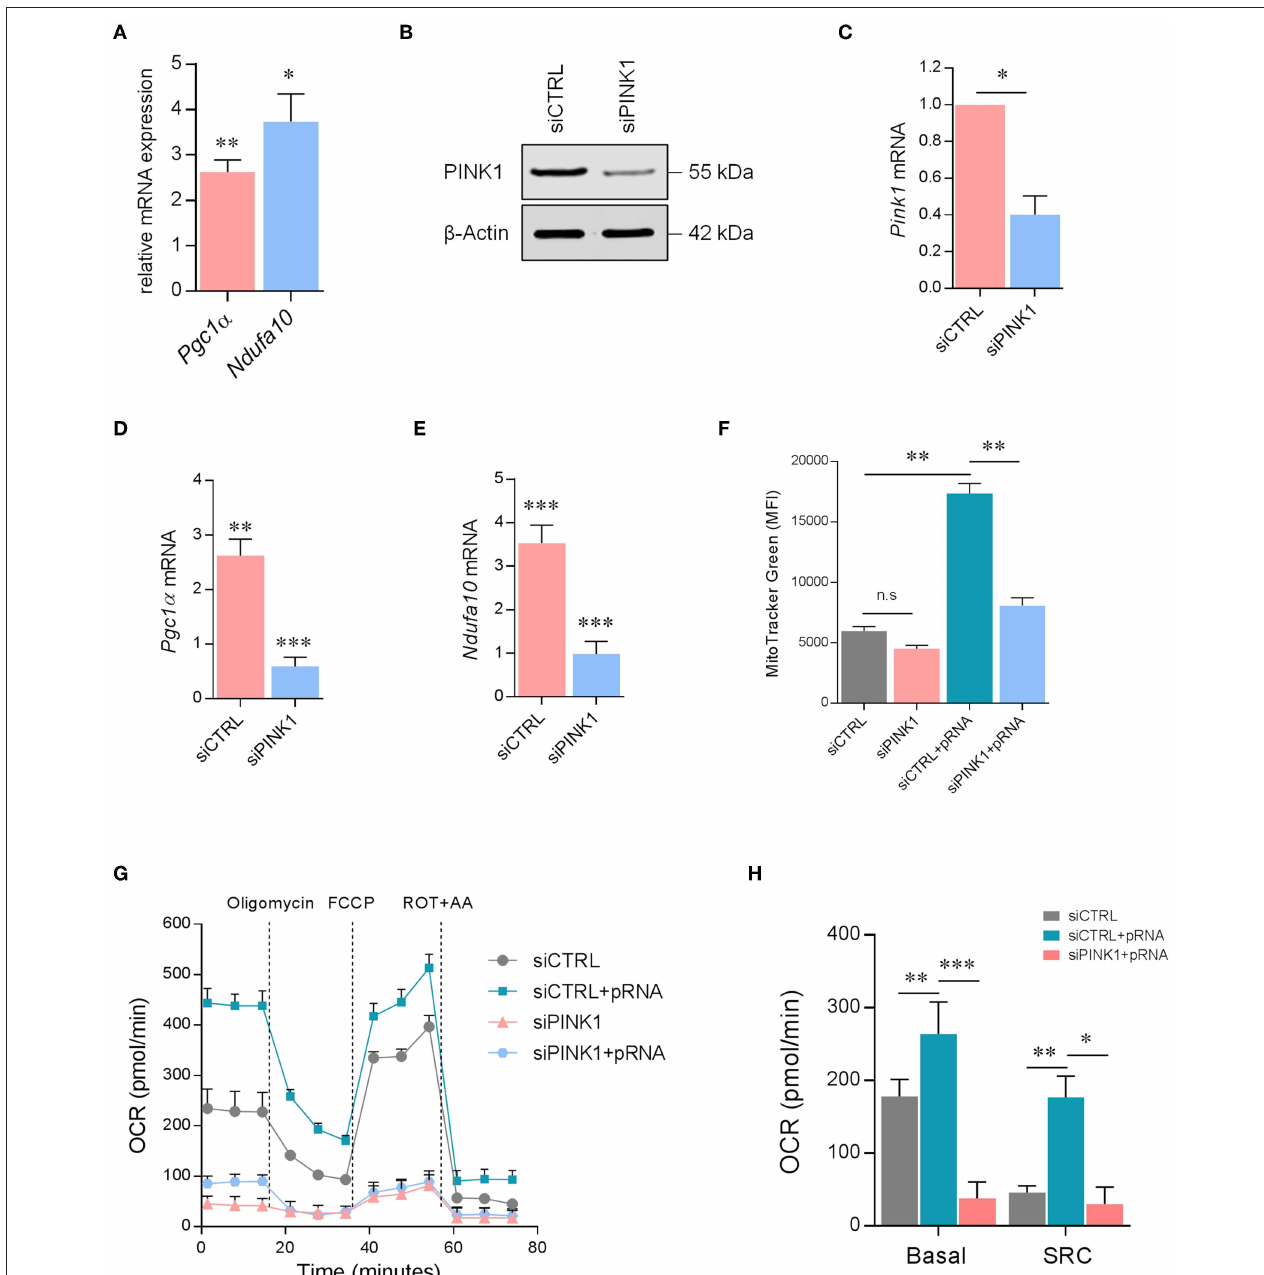
FIGURE 3 | PINK1 is required for OXPHOS in pRNA-stimulated DC. (A) Relative mRNA levels were analyzed after 12h of pRNA stimulation by (qPCR) and normalized to β -actin expression by using the 2 11 CT method. Data represents Mean ± SEM of three independent experiments performed in triplicate. * p < 0.05; ** p < 0.01 (two-way ANOVA). (B) DCs transfected with a control siRNA (siCTRL) and pool of two PINK1-targeting siRNAs. Expression of PINK1 was determined by western blotting. β -actin was used as a loading control. (C) PINK1 mRNA levels were analyzed by qPCR and normalized to β -actin expression by using the 2 11 CT method. Data represents Mean ± SEM of three independent experiments performed in triplicate. * p < 0.05 (Student’s t -test). (D,E) mRNA levels were analyzed after 12h of pRNA stimulation by (qPCR) and normalized to β -actin expression by using the 2 11 CT method. Data represents Mean ± SEM of three independent experiments performed in triplicate. ** p < 0.01; *** p < 0.001 (Student’s t -test). (F) Mean fluorescence intensity of DCs stained with MitoTracker Green FM after 12h of pRNA stimulation. Data represents Mean ± SEM of three independent experiments performed in triplicate. ** p < 0.01 (Student’s t -test). (G) Mitochondrial fitness test of DCs stimulated with pRNA for 12h. Data represents mean ± SEM of three independent experiments performed in triplicate. (H) Data was collected within same experiments as (G) , but is shown separately for better understanding. Data represents mean ± SEM of three independent experiments performed in triplicate. * p < 0.05; ** p < 0.01; *** p < 0.001 (Student’s t -test).